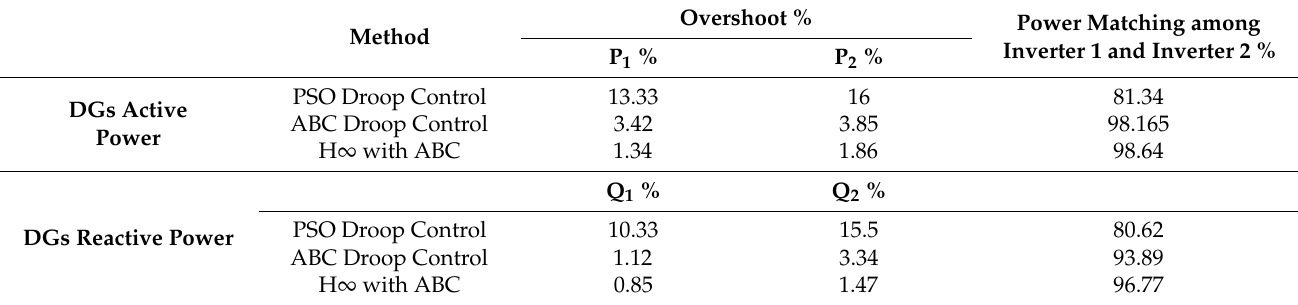
Table 3. Comparison of power sharing with different